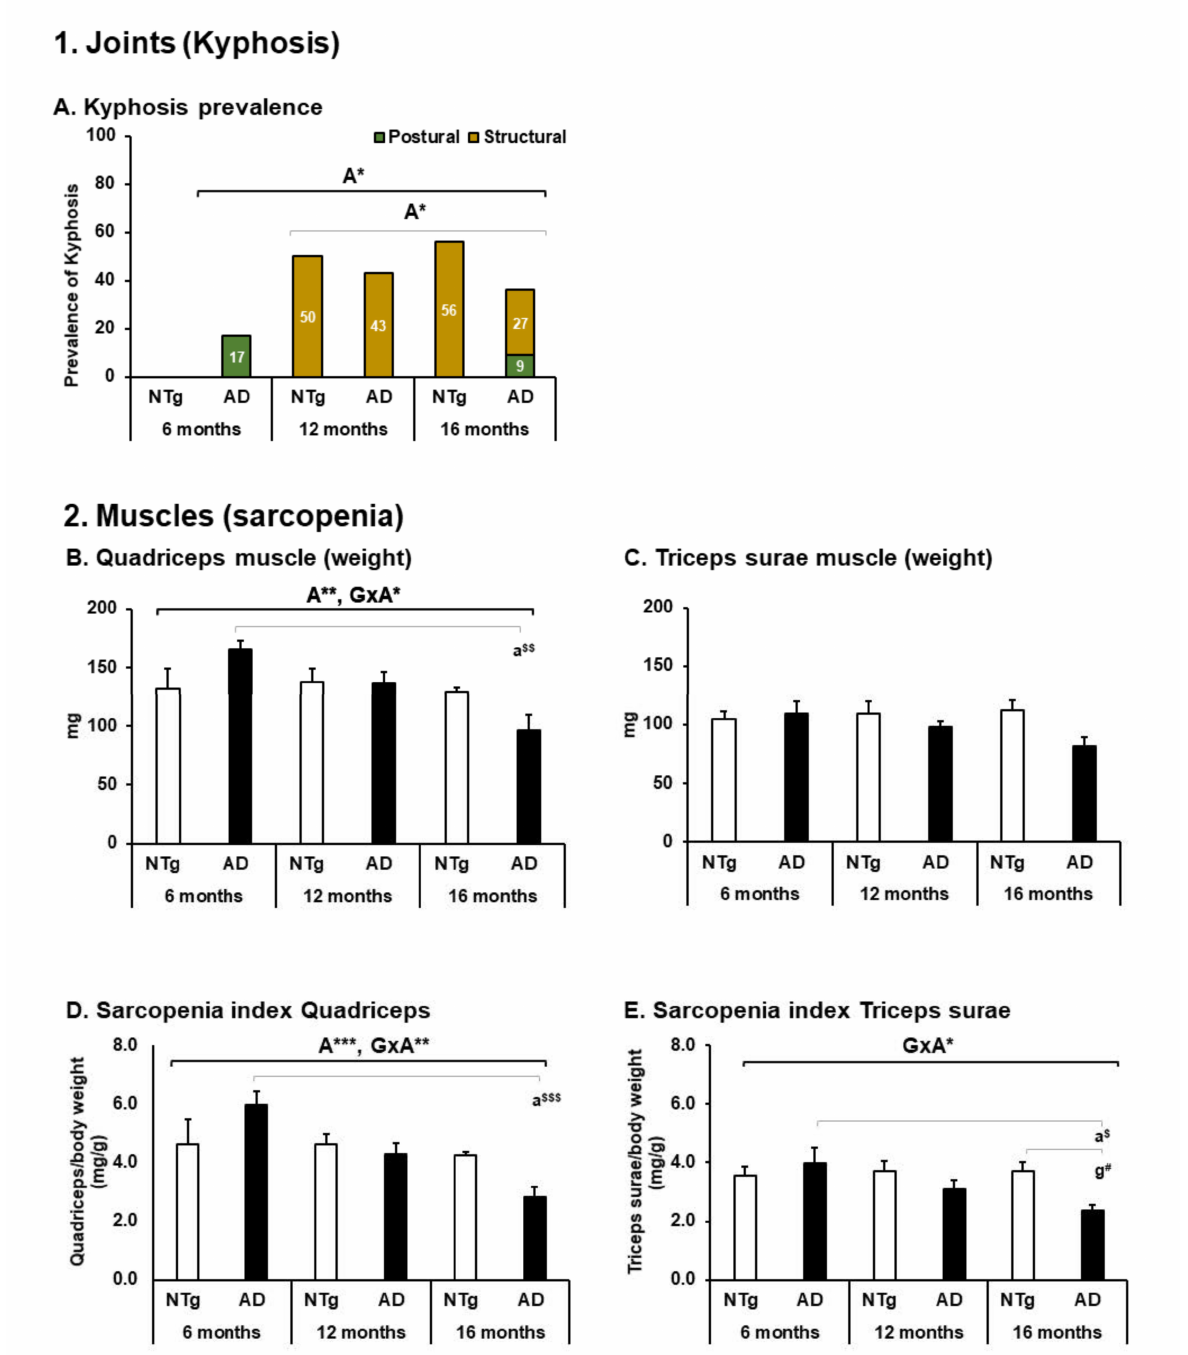
Figure 5. BODY STRUCTURE—joints and muscles. 1. Joints (Kyphosis), ( A ) kyphosis prevalence, the results are expressed as prevalence (%). Statistics: Fisher’s exact test; Age effect is expressed as ( A ); * p < 0.05. 2. Muscles (sarcopenia), ( B ) quadriceps muscle (weight); ( C ) triceps surae muscle (weight); ( D ) Sarcopenia index Quadriceps; ( E ) Sarcopenia index Triceps surae; the results are expressed as mean ± SEM. Statistics: one-way ANOVA, Age effect expressed as ( A ); Genotype effect expressed as ( G ); Genotype and Age interaction effect is expressed as (GxA). * p < 0.05, ** p < 0.01 and *** p < 0.001 followed by post-hoc Bonferroni test, * p < 0.05, ** p < 0.01, and *** p < 0.001; differences between NTg vs. 3xTg-AD are expressed (g): # p < 0.05, differences between age in 3xTg-AD group are expressed (a): $ p < 0.01, $$ p < 0.01, and $$$ p <